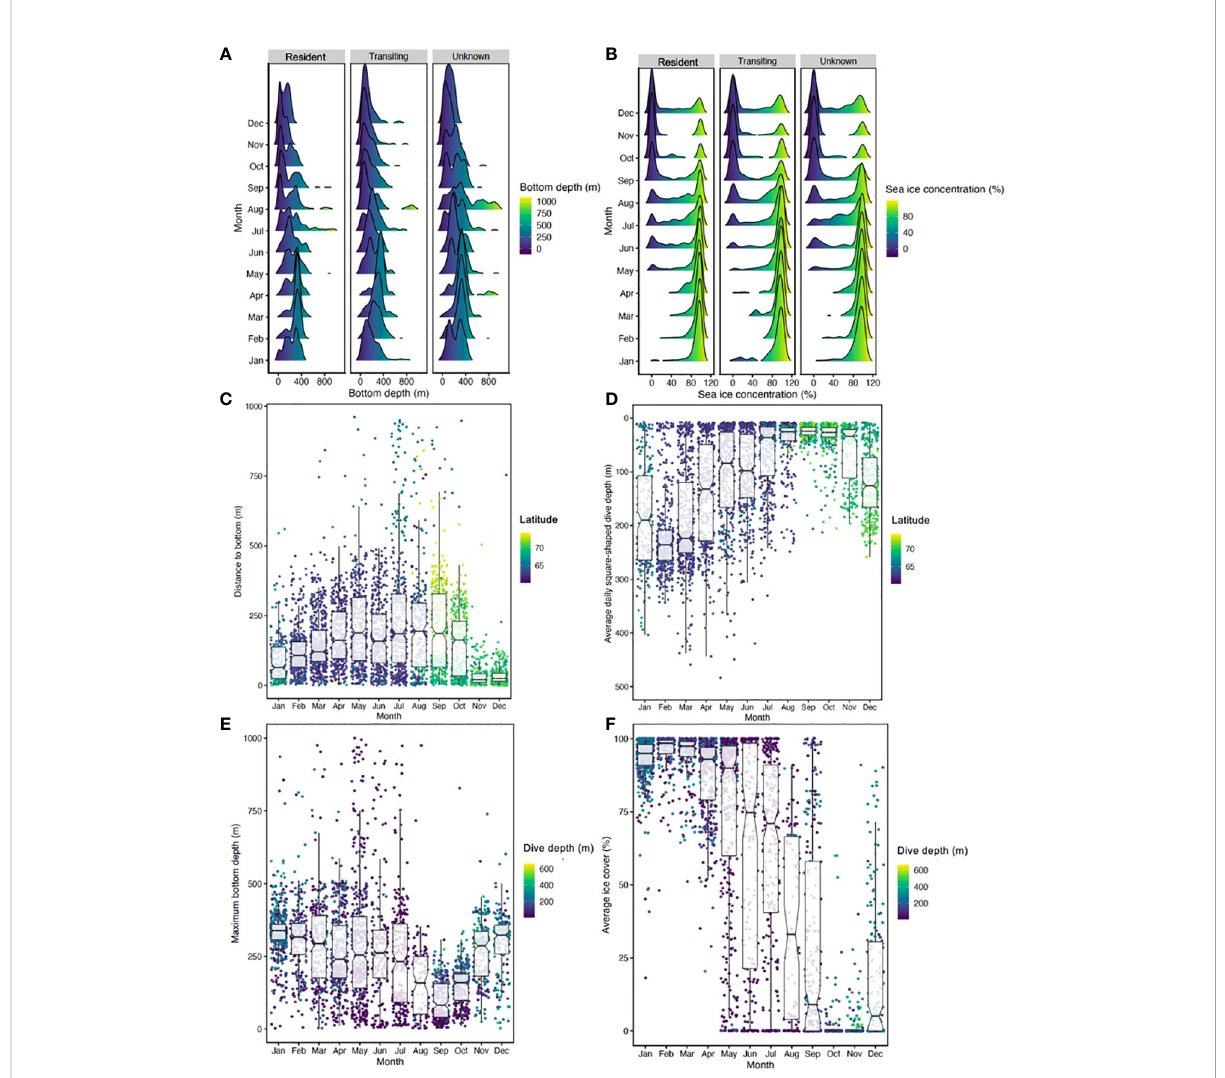
FIGURE 5 (A) Bathymetric (bottom depth) data associated with HSSSM predicted locations for all bowhead whales (n=25) by behavioural state and month. Shallow bathymetry is indicated by warm colours and deep bottom depths are denoted by cool colours. Due to location uncertainty, predicted locations occurring on land were removed as bathymetric data could not be determined for these positions. (B) Sea ice concentration associated with HSSSM predicted locations by behavioural state (resident, transit and unknown) and month where warm colours indicate low